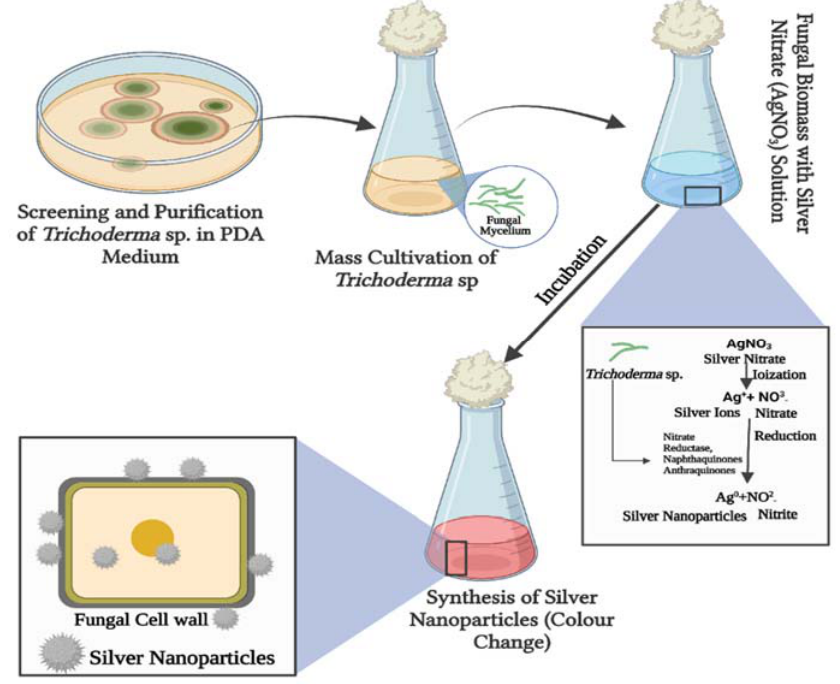
Figure 3. Schematic illustration of biosynthesis mechanism of silver nanoparticles (AgNPs) using Trichoderma species. The present figure was created by BioRender.com.